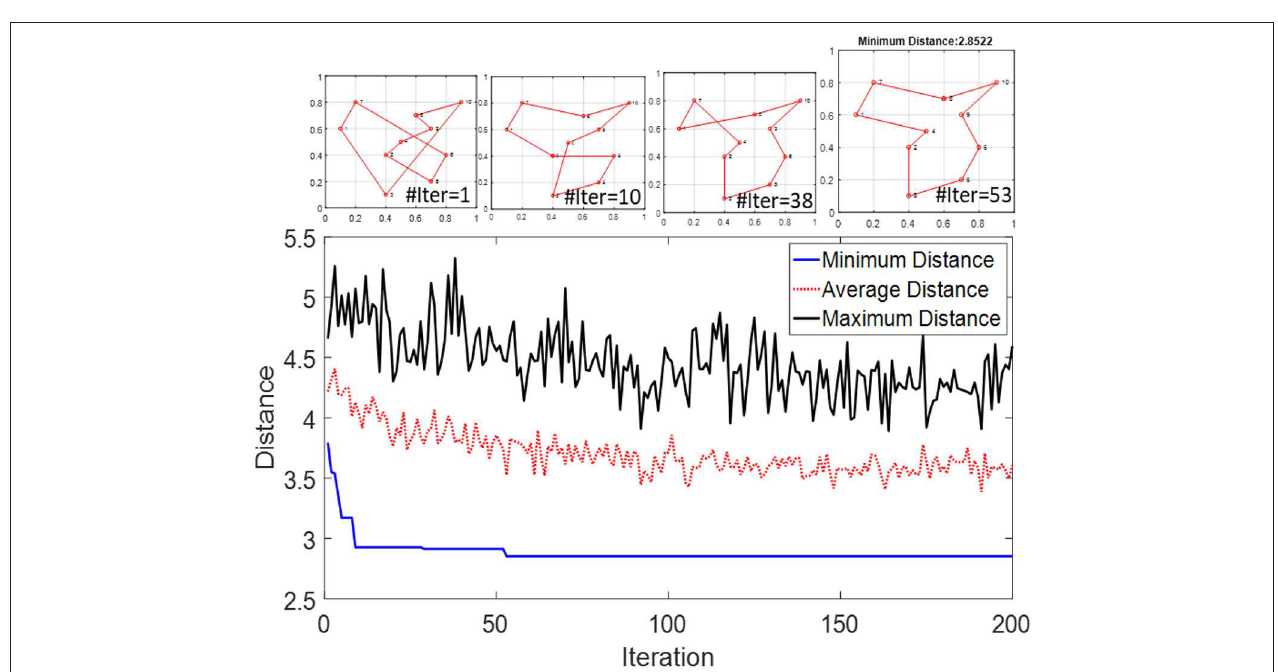
FIGURE 8 | Distance of the best solution to a 10-city TSP in each iteration of SI-SNN.